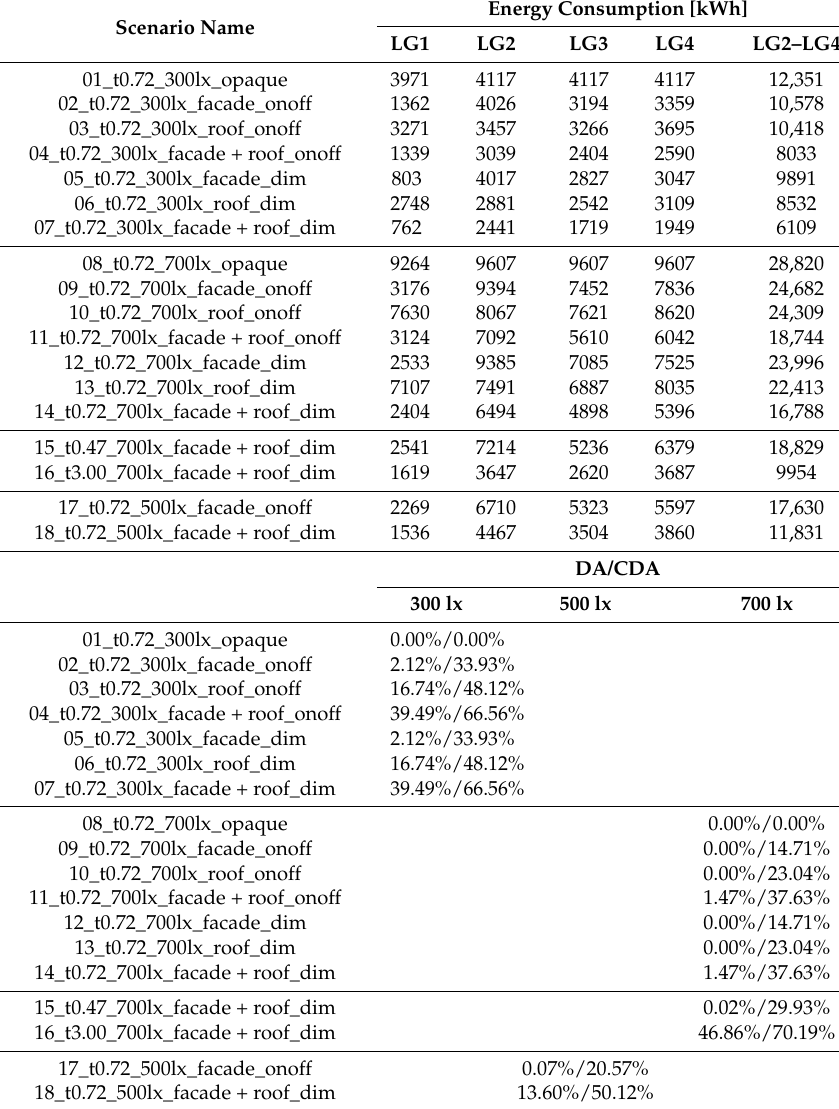
Table A2. Absolute electricity demand for AL and daylight indicators of all